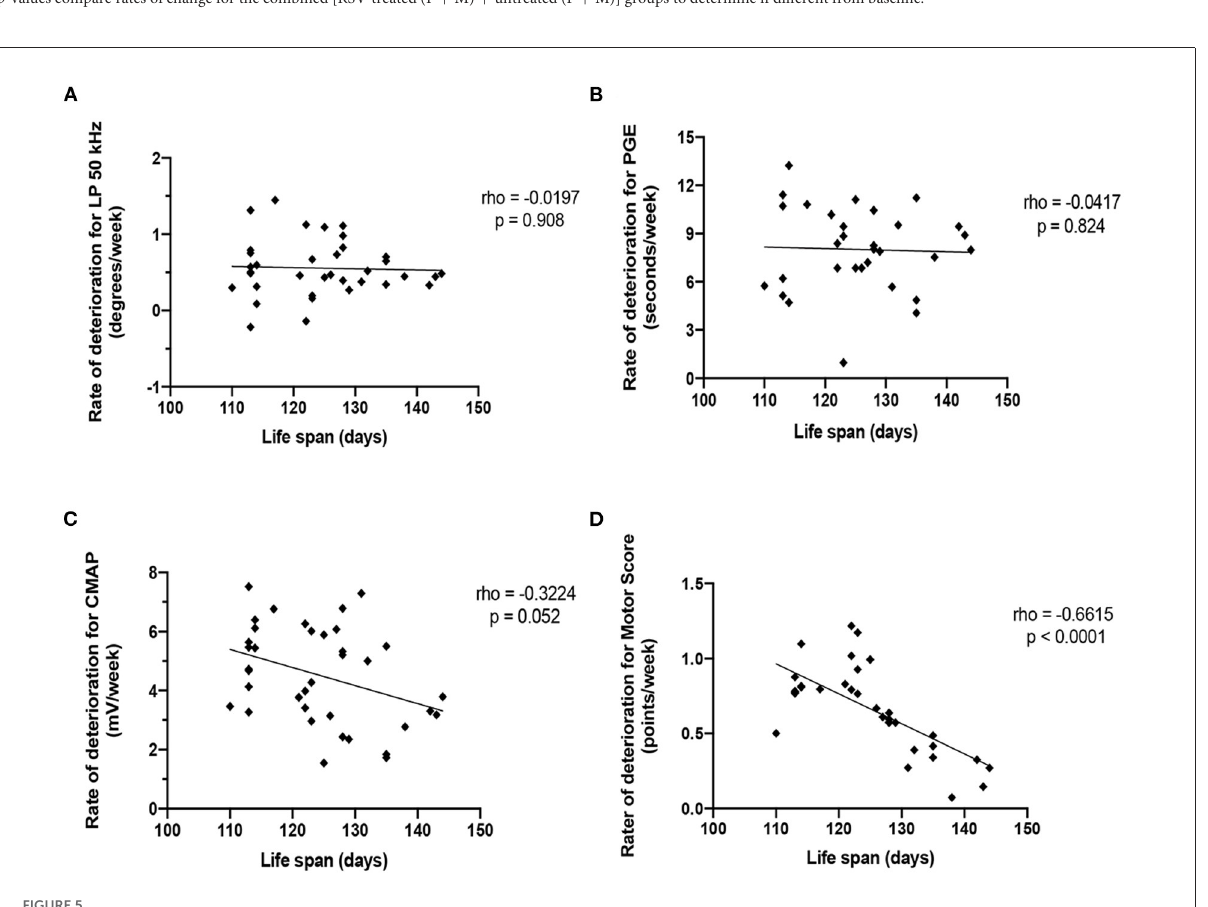
FIGURE5 Correlation of the rate of deterioration of each biomarker with life span. (A) LP 50kHz. (B) PGE. (C) CMAP amplitude. (D) Motor